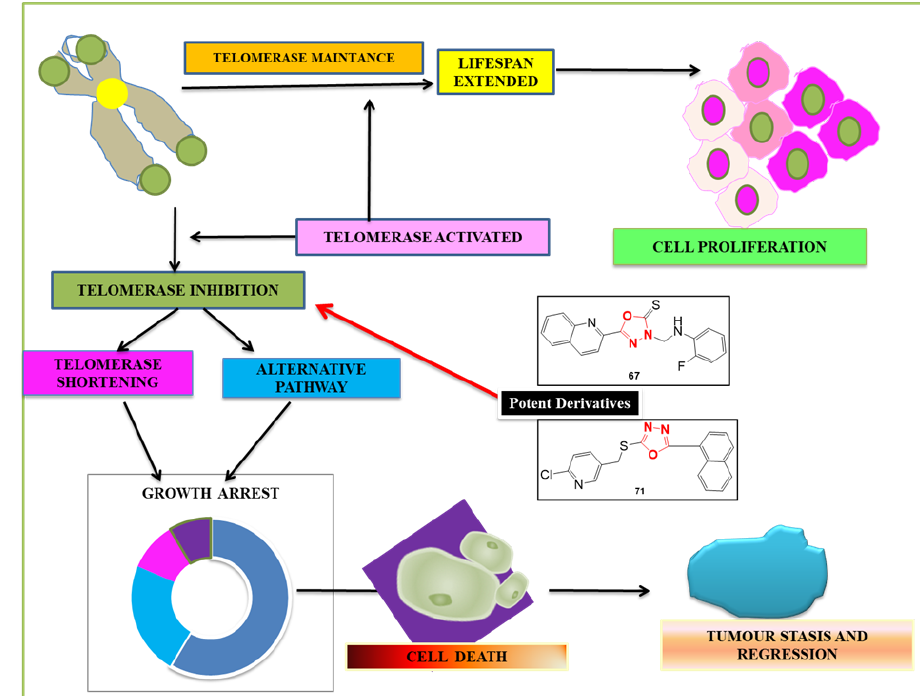
Figure 9. Telomerase enzyme and cell proliferation .